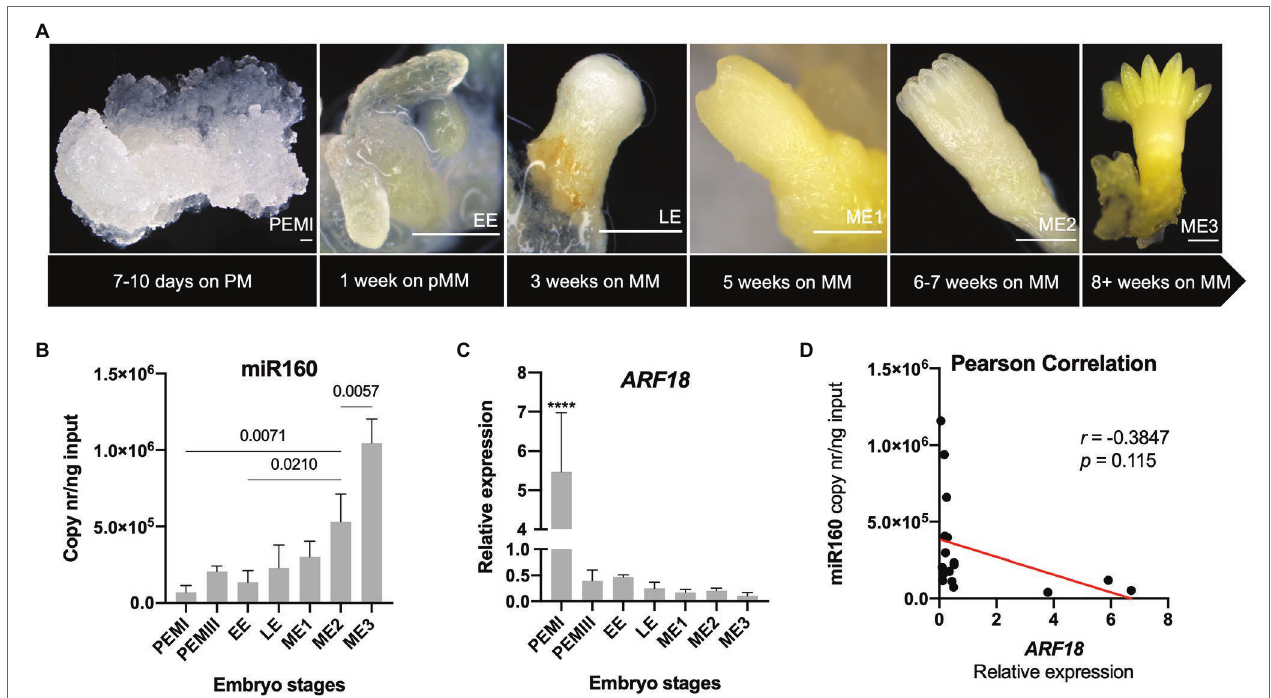
FIGURE 5 | Expression profiles of Picea abies miR160 and ARF18 during somatic embryogenesis. (A) Different developmental stages of somatic embryogenesis, from proembryogenic masses (PEMI) on proliferation medium (PM) to fully mature embryo (ME3) on maturation medium (MM). Bars correspond to 500 μ m. (B) Absolute quantification of miR160 (copy nr/ng input) across the selected embryo developmental stages. Significant differences of pairs of bars are marked with the p value, obtained by one-way ANOVA and Tukey’s multiple comparison test. (C) Relative expression levels of ARF18 during the selected stages of P. abies somatic embryo development. CDC2 , EF1- α , and PHOS were used as reference genes. (D) Pearson correlation of expression levels between miR160 and ARF18 . Error bars correspond to the SD for the RT-qPCR values of three biological replicates, except for early embryos (EEs) for which two biological replicates were